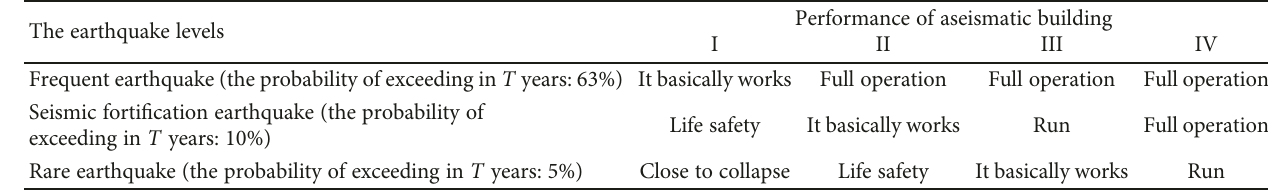
Table 1: Performance of aseismatic